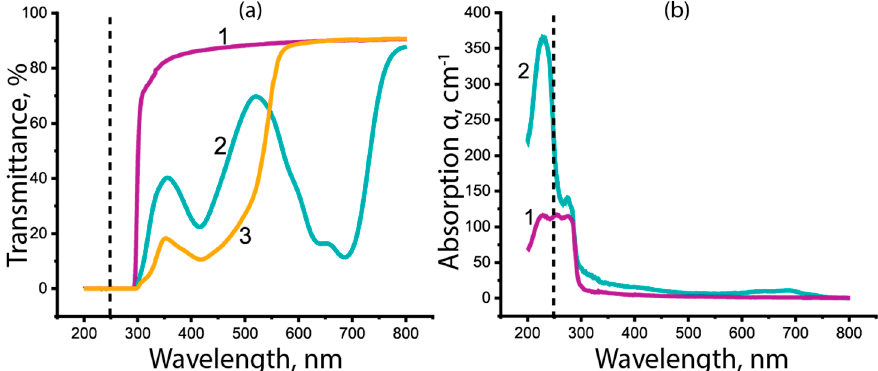
Figure 3. ( a ) Transmission spectra of (1) colorless PMMA of 1 mm thickness, (2) green PMMA of 3 mm and (3) yellow PMMA of 4 mm; ( b ) absorption coefficients in (1) colorless and (2) green PMMA. A dashed line designates the KrF laser